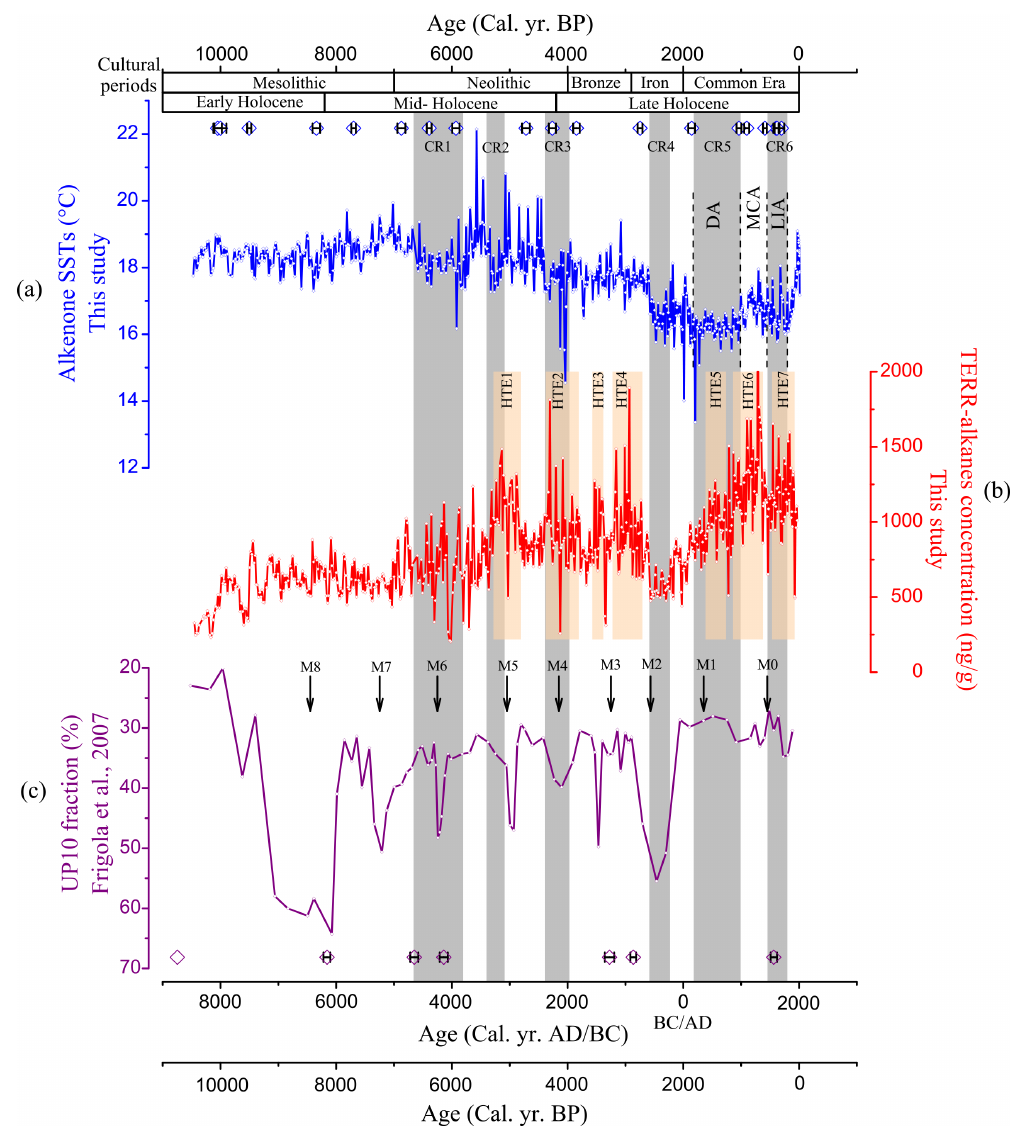
Figure 2. Alkenone SSTs and TERR-alkane concentrations at the KSGC-31_GolHo-1B core site over the past 10000 years. (a) The AMS 14 C radiocarbon dates for gravity core KSGC-31 are indicated by the blue diamonds; vertical dashed lines highlight the major periods of the Common Era. (b) TERR-alkane concentrations. (c) The UP10 fraction from core MD99-2343 (Frigola et al., 2007), (reversed vertical axis). Age control points for core MD99-2343 are represented by the purple diamonds. The vertical grey bars represent the six NW Mediterranean CRs no. 1–6. Vertical light brown bars indicate the periods of high flood intensity based on the high TERR-alkane